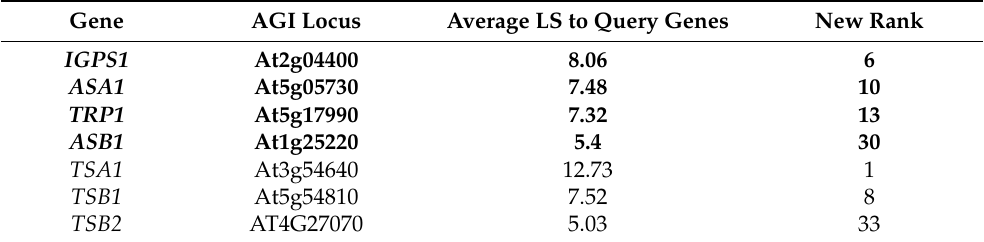
Table 4. Coexpression of IGPS1 , ASA1 , TRP1 , and ASB1 as a bait set under general conditions in the ath-u.c2-0 platform. The new ranks of genes are calculated in respect to the query genes. Logit Score (LS) was used as a coexpression index. Higher LS indicates a better coexpression